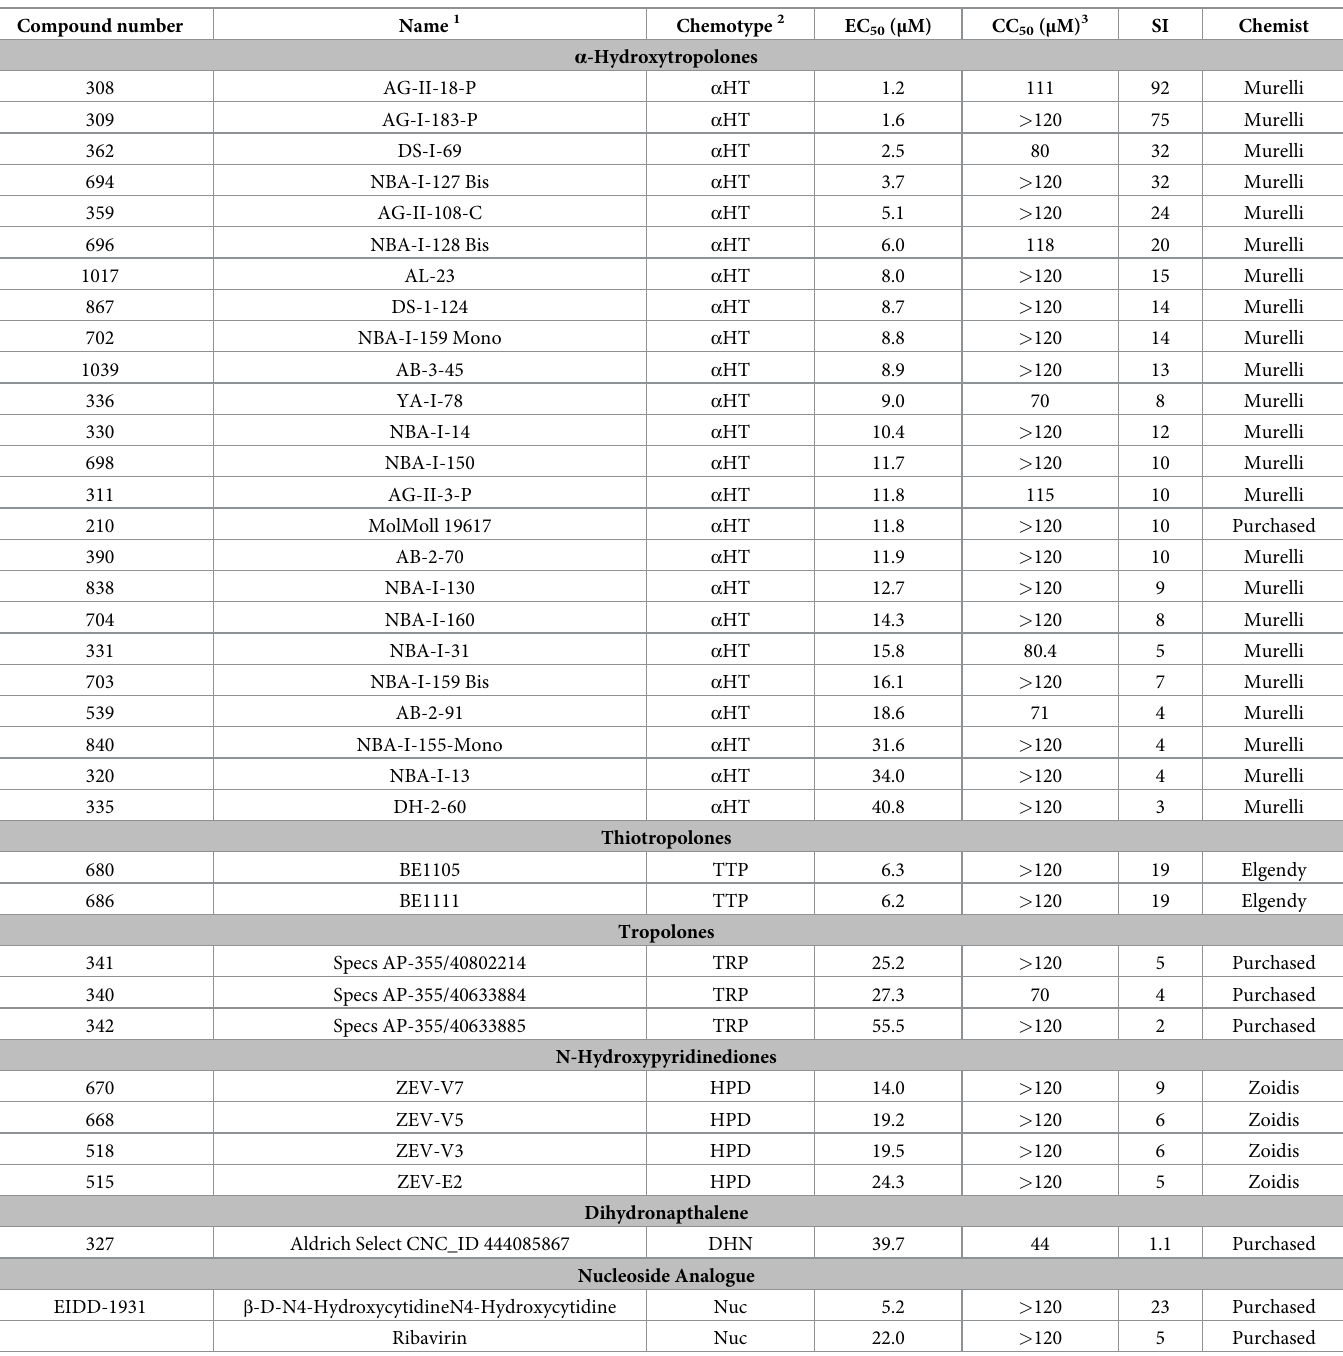
Table 1. Top antiviral